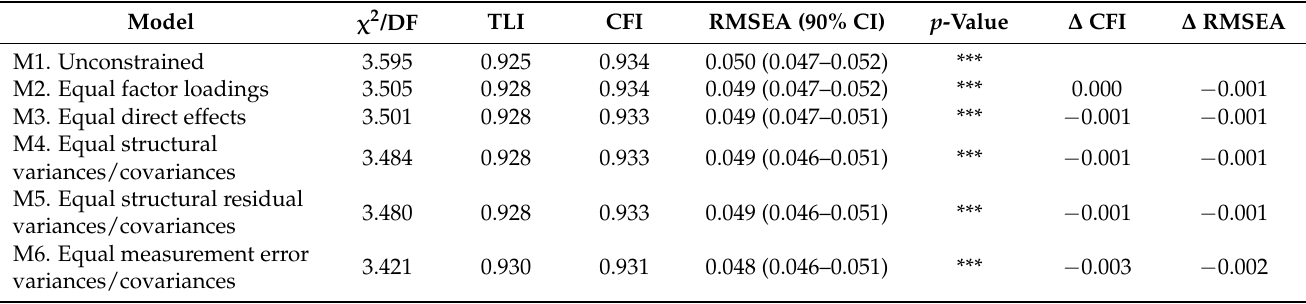
Table 7. Multigroup analyses results for